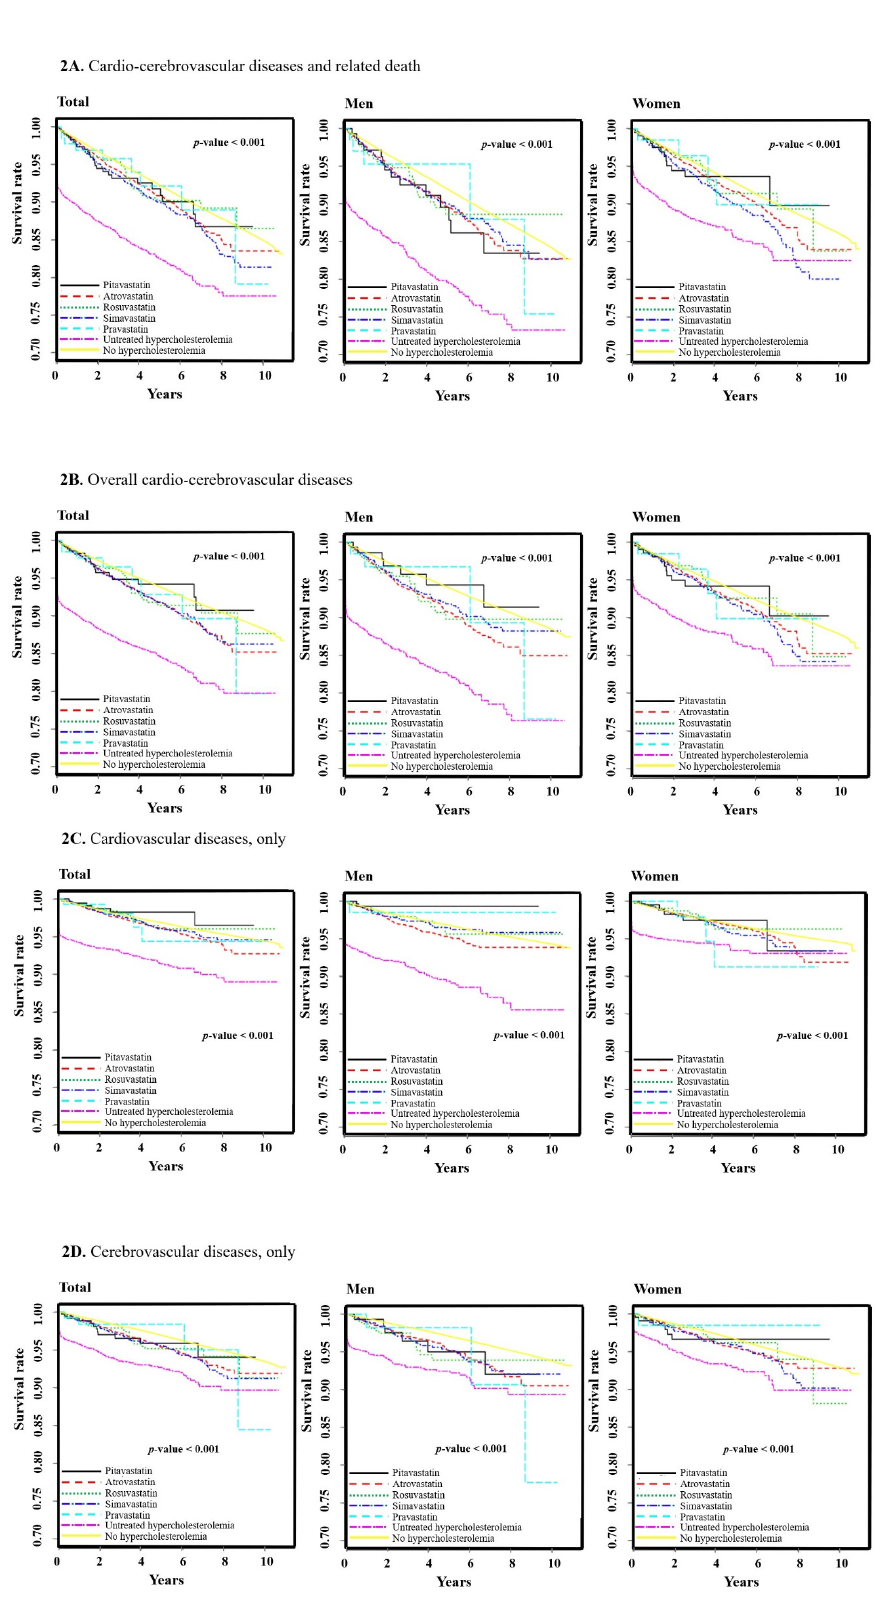
Figure 2. Kaplan–Meier estimates for the development of cardiocerebrovascular diseases and related deaths according to statin usage. ( A ) Cardiocerebrovascular diseases and related death. ( B ) Overall cardiocerebrovascular diseases. ( C ) Cardiovascular diseases only. ( D ) Cerebrovascular diseases only. p -Values are from log-rank tests.